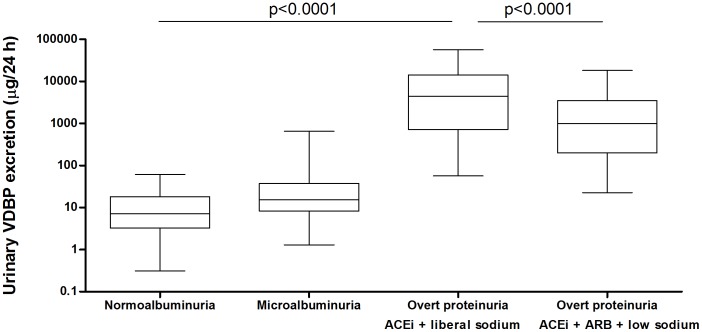
Urinary vitamin D binding protein (uVDBP) levels in patients with normoalbuminuria, microalbuminuria, and overt proteinuria.Box-whisker plots indicating the median, interquartile range, and range of 24-h uVDBP per patient category: general population with normoalbuminuria, general population with microalbuminuria, chronic kidney disease with overt proteinuria treated with ACE inhibitor and liberal sodium diet, and chronic kidney disease with overt proteinuria treated with ACE inhibitor+ARB+low sodium diet. UVDBP increased with albuminuria (first three groups, p<0.001) and responded to intensification of anti-proteinuric treatment (two last groups, p<0.001).